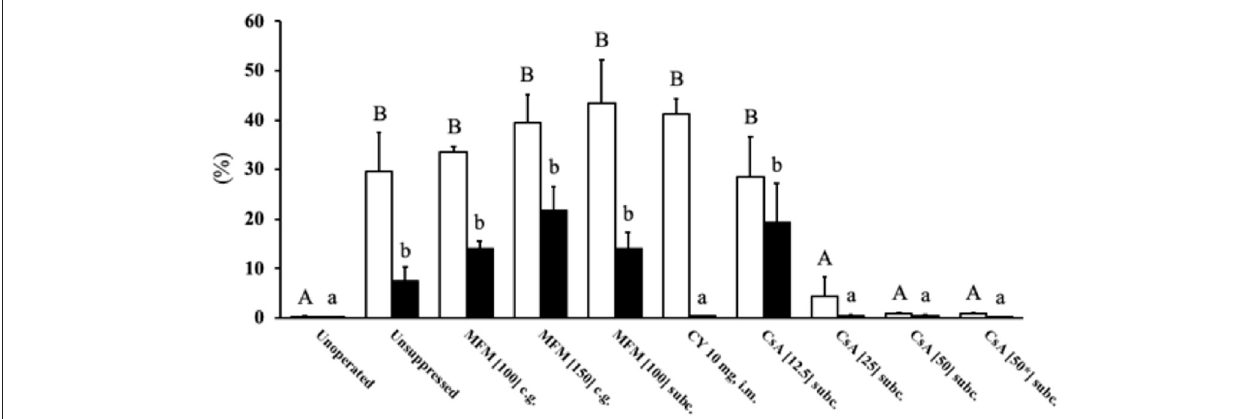
FIGURE 3 | T and B cell levels within transplants from Study 2. After 14 days post-surgery, there were high levels of T cells within the unsuppressed, MFM, CY and CsA 12.5 mg/kg/day treatment groups, compared to the unoperated and CsA 25 and 50 mg/kg/day groups. The only difference between the T and B cell levels was that in the CY treatment were low levels of B cells were observed. The open bars show the percent of CD3 immunostained cytoplasm which was used to estimate the amount of T cells, whereas the solid black bars show the percent of PAX5 immunostained nuclei used to estimate the number of B cells. The unoperated tissue was collect from birds at 16 dph. For all other treatments, the tissue was collected at 14 days post-surgery (16 dph). The dose (mg) of the drug indicates the amount given per kg per day. * Indicates the treatment where 50 mg/kg/day of cyclosporin A was started the pre-surgery. Data are means ± SEM of n = 3–5. Statistics: one-way ANOVA followed by a post-hoc, P ≤ 0.05. A,B Means for percent of CD3 with no common superscript differ significantly. a,b Means for percent of PAX5 with no common superscript differ significantly. dph, days posthatch; MFM, mycophenolate mofetil; CY, cyclophosphamide; CsA, cyclosporin A; CG, crop gavage; SC, subcutaneous injection; IM, intramuscular injection.